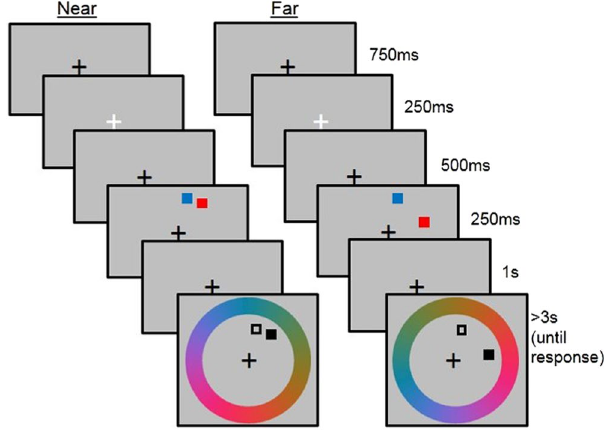
Figure 1. The trial sequence for the Near and Far conditions for Experiment